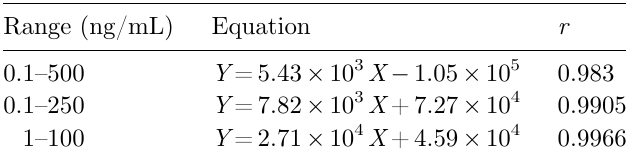
Table 8. Example of linear regression analysis of standard solutions for cocaine by a HPLC/MS/MS method